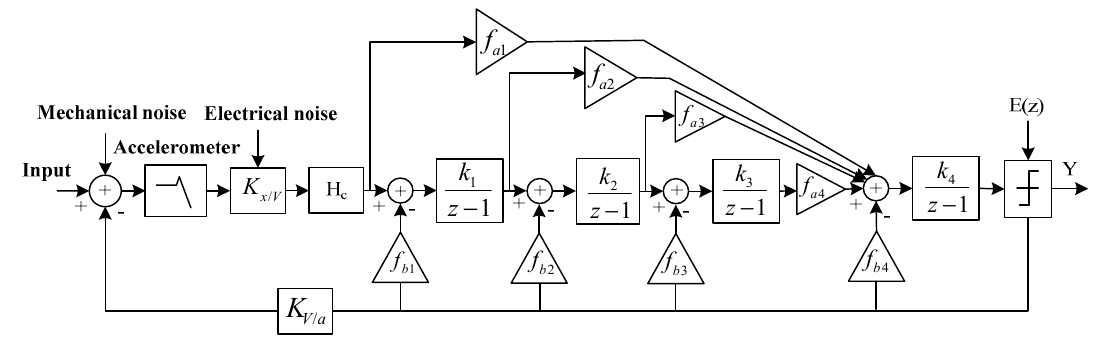
Figure 6. Analytical model of Σ∆ micro-accelerometers. Table 3. The modulator coefficient.